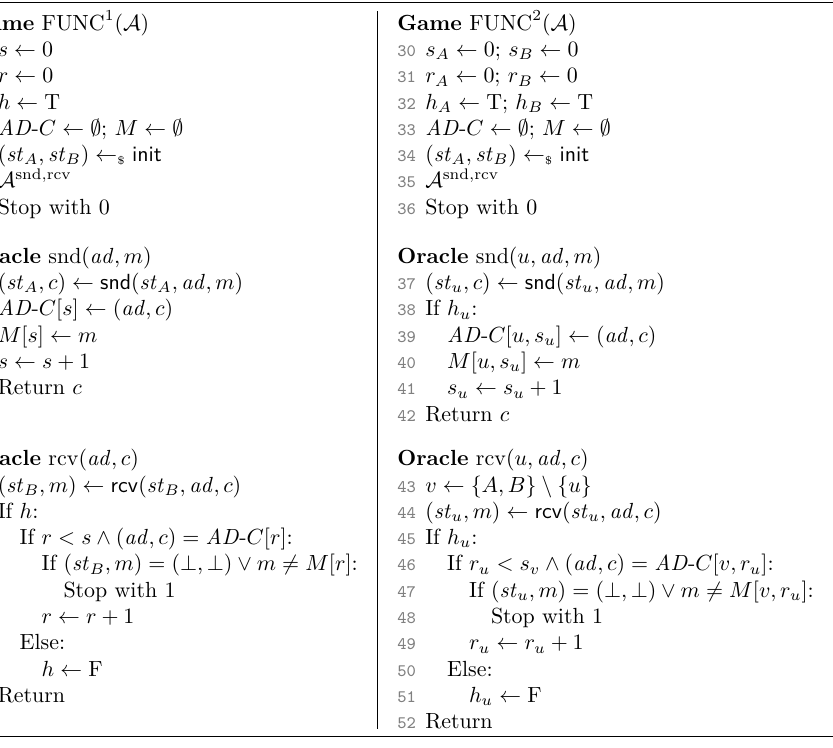
Figure 2: Functionality game for unidirectional (left) and bidirectional (right)